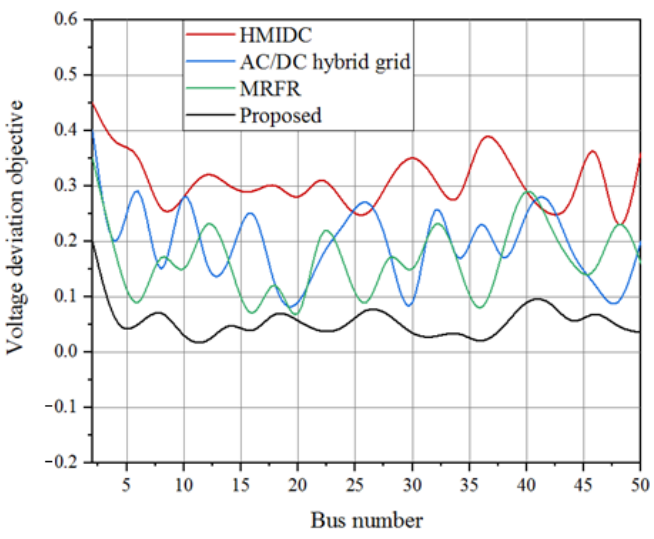
Figure 8. Convergence curves for voltage deviation of IEEE 50-bus system.